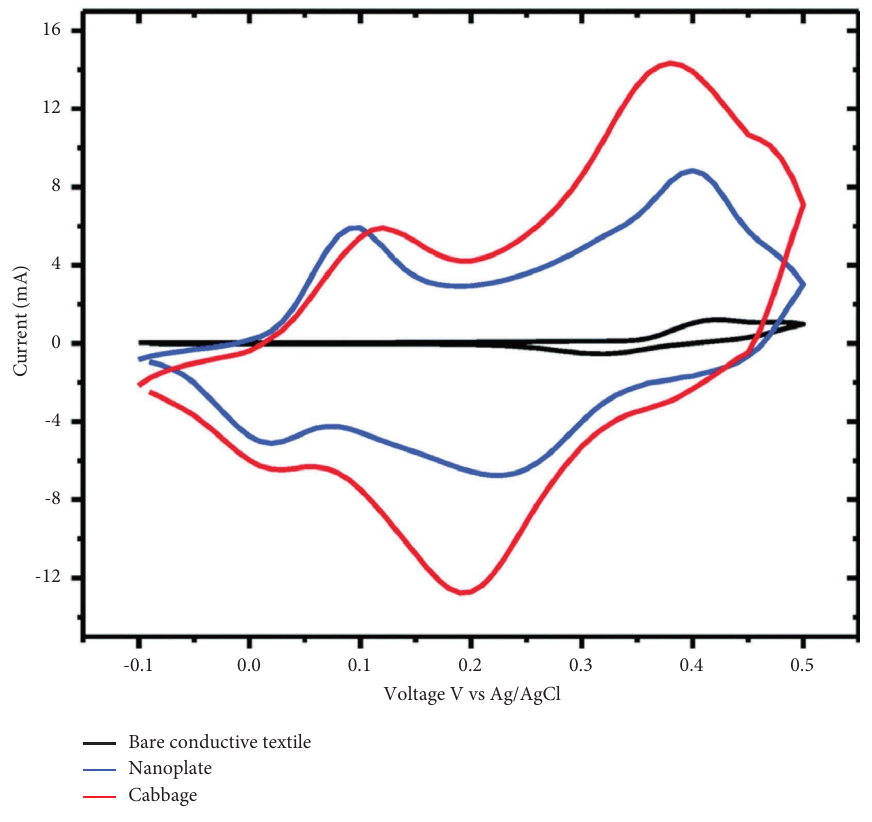
Figure 8: CV curve of cobalt hydroxide sample